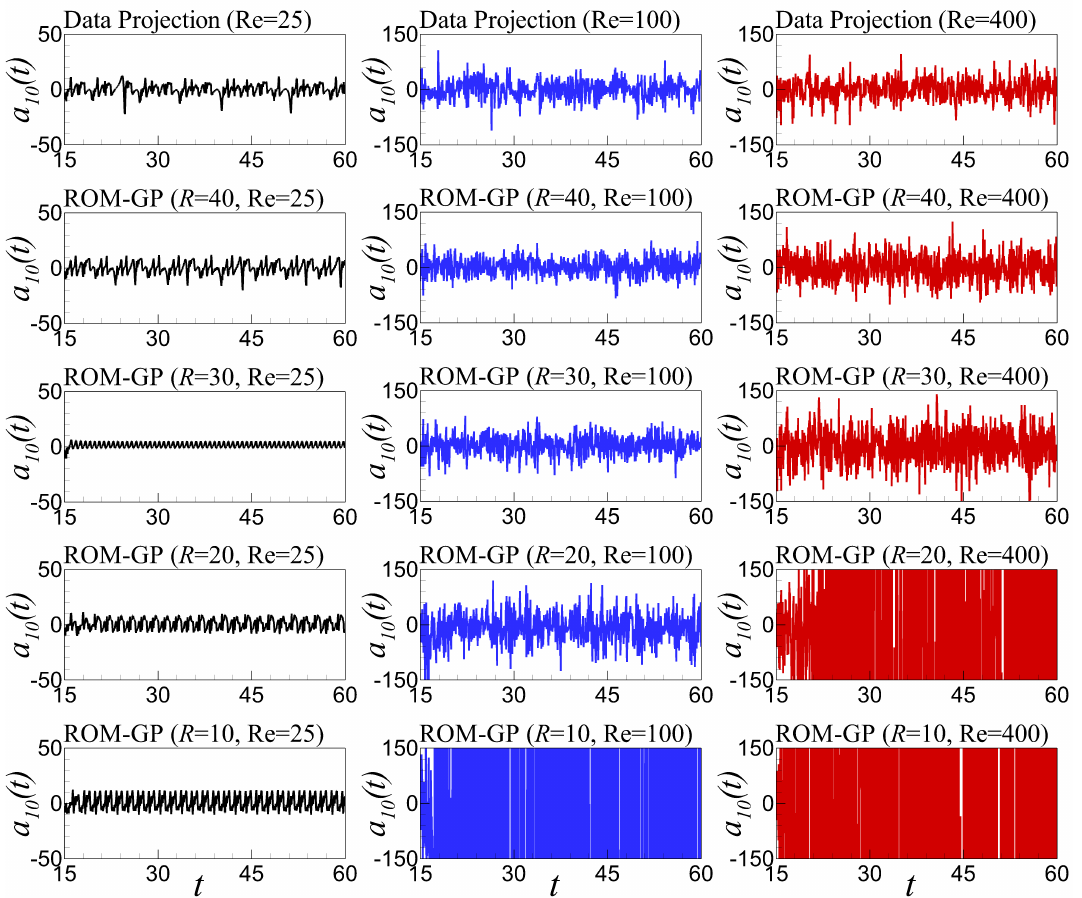
Figure 9. Time series evolution of the tenth modal coefficient, a 10 ( t ) between t = 15 and t = 60 for FOM projection and standard ROM-GP with varying Re (Re = 25,100,400) and POD modes ( R =